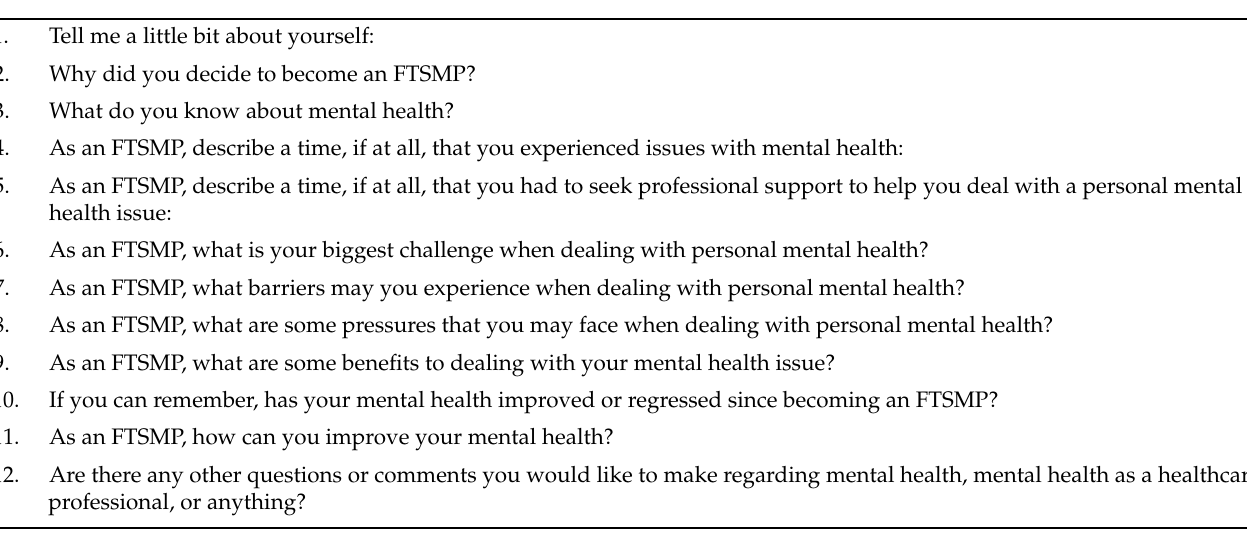
Table 3. Interview